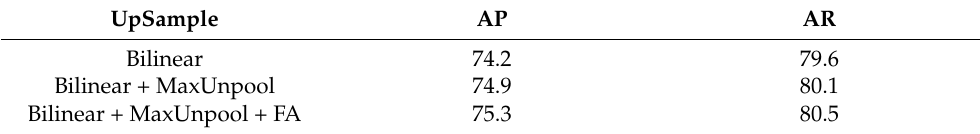
Table 4. Ablation experiment of the Fusion Decoder. FA denotes the FeatureAggregation module.